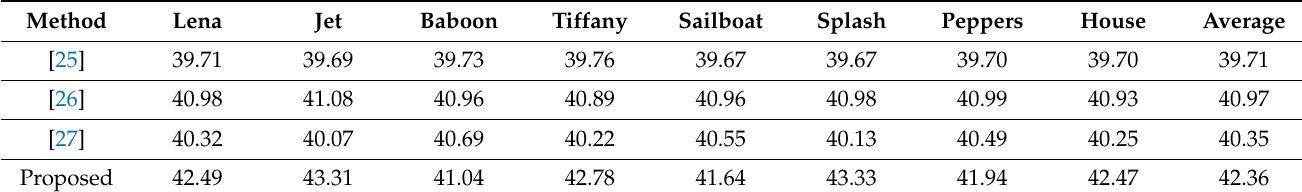
Table 3. PSNR comparisons with [25–27] (in